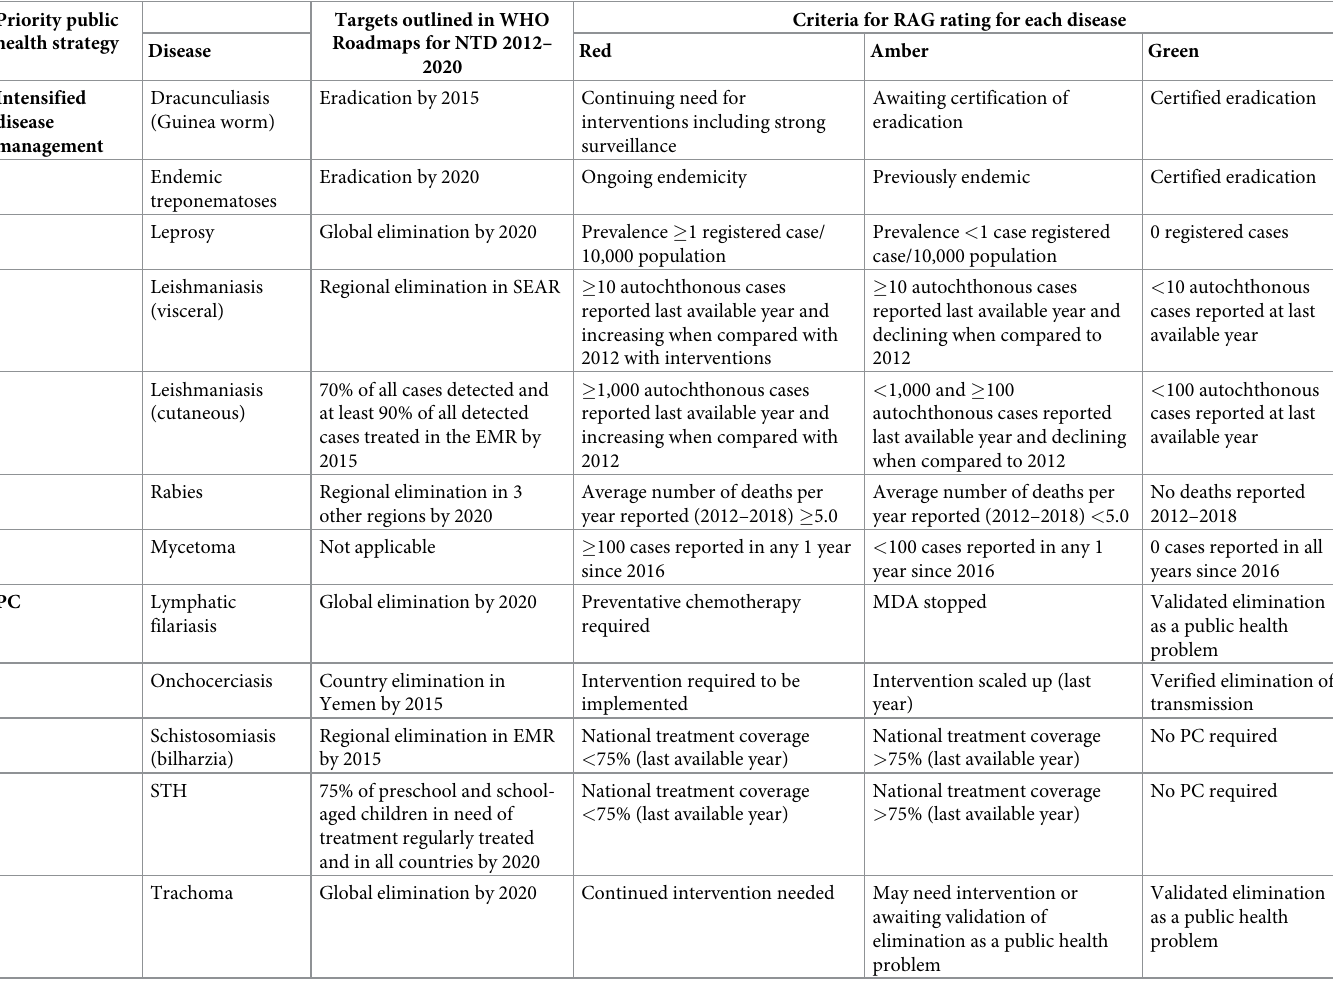
Table 2. List of NTDs with targets extracted from WHO Roadmap for 2012–2020 with priority public health approaches (intensified disease management or PC) and criteria for RAG